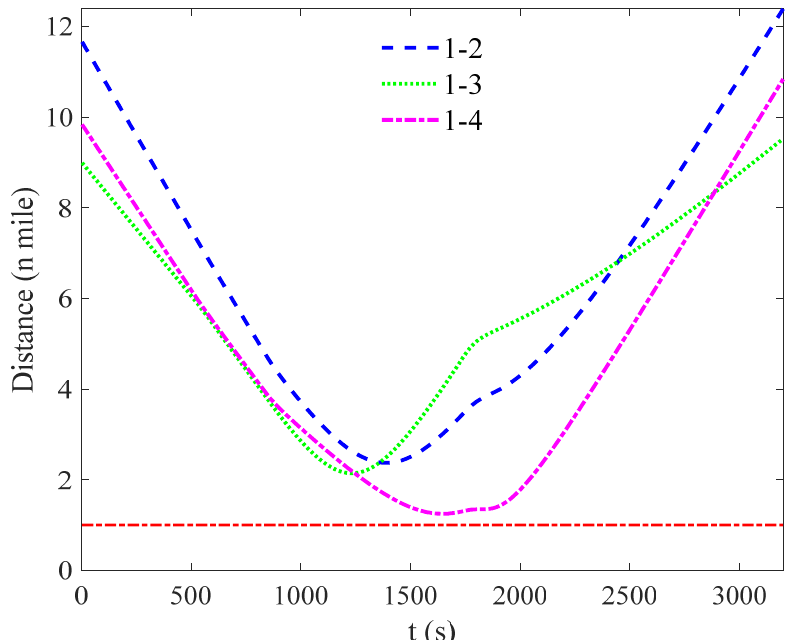
Figure 21. The situation of four ships at t = 3200 s in scenario 3.